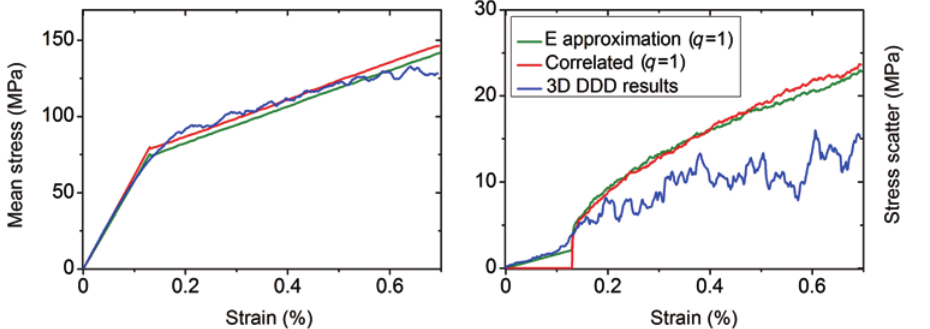
Figure 12: Left: average stress; right: stress standard deviation; blue line: DDD simulations results; red line: correlated stochastic simula- tions using correlation factor q = 1; green line: correlated stochastic simulations using correlation factor q = 1 and statistically distributed effective elastic